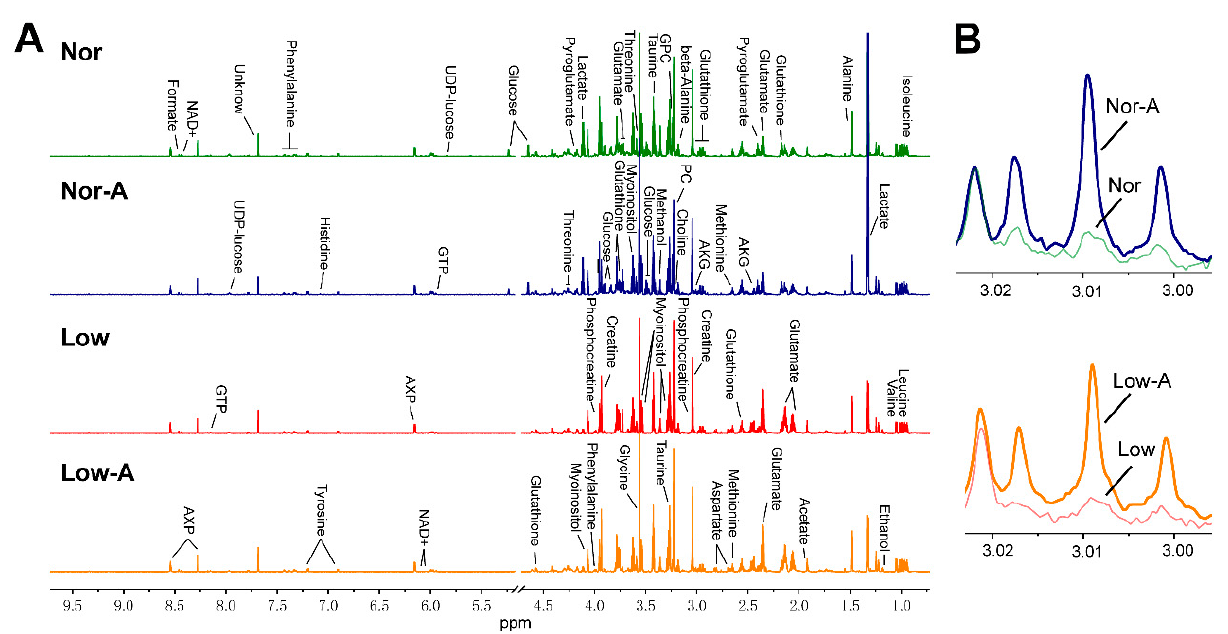
Figure 2. Average 850 MHz 1 H nuclear magnetic resonance (NMR) spectra recorded on aqueous extracts derived from the Nor, Nor-A, Low, and Low-A groups of C2C12 myoblasts. ( A ) Comparison of the average NMR spectra of the four groups. The vertical scales were kept constant in all the 1 H NMR spectra. The water region (4.7–5.2 ppm) was removed. ( B ) Local amplified regions of α -Ketoglutarate (AKG) peaks. Blue/green/yellow/red line: spectral regions from the Nor/Nor-A/Low/Low-A groups. AKG, α -ketoglutarate; PC, O-phosphocholine; GPC, sn-glycero-3-phosphocholine; UDP-glucose, Uridine diphosphate glucose; GTP, sn-glycero-3-phosphocholine; NAD+, nicotinamide adenine dinucleotide; AXP, adenine mono/di/tri phosphate.